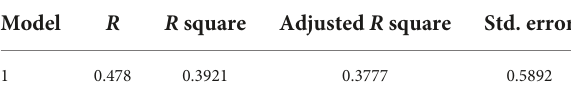
TABLE 4 Regression analysis—model summary.